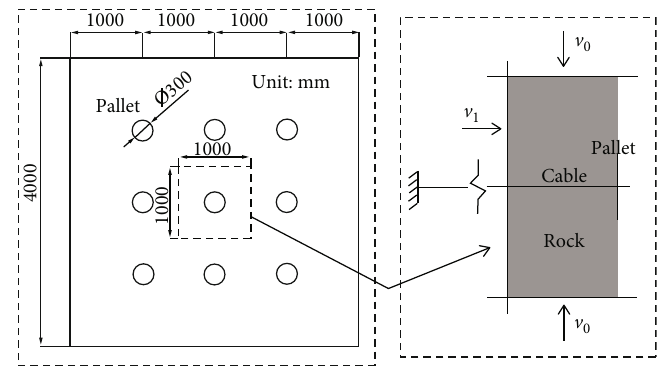
Figure 5: Engineering model and experiment model of CR rock.